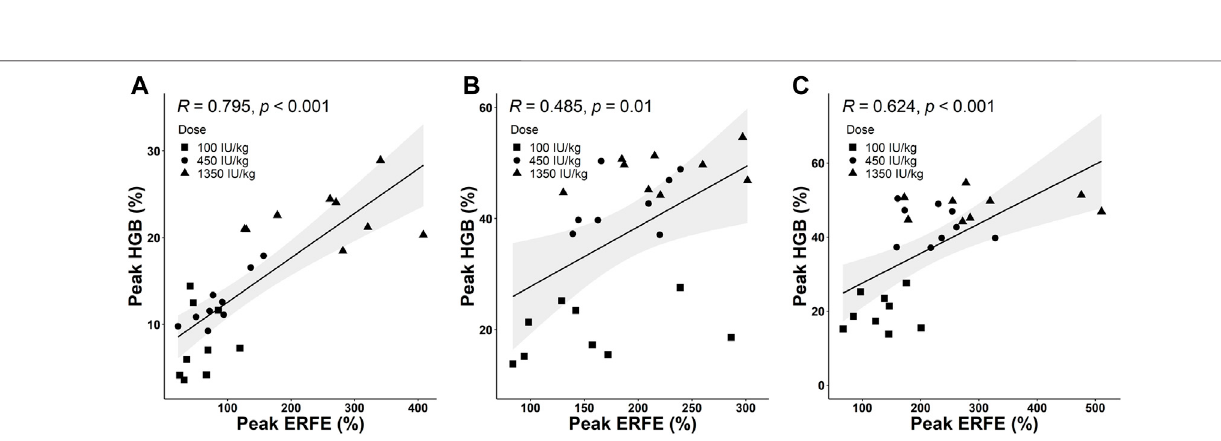
FIGURE 5 | (A) Diurnal pro fi le of plasma EREF in nine control rats. (B) Baseline ERFE concentrations measured at different time points throughout the day across four successive days in healthy rats without any treatment. Data are presented as means ± SD ( n = 3 for each time point).